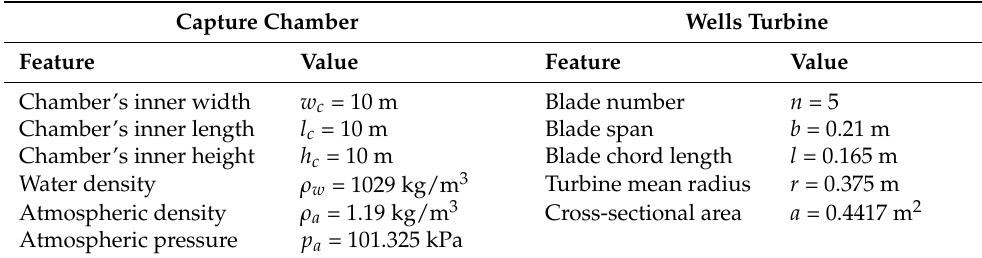
Table 3. Parameters of the integrated oscillating water